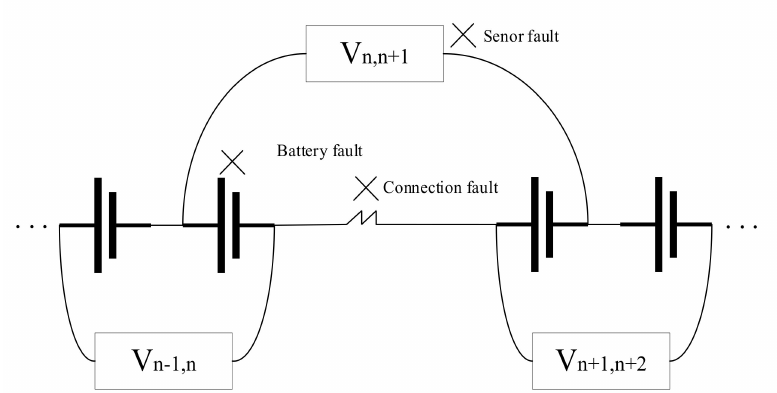
Figure 1. Connection of battery pack and